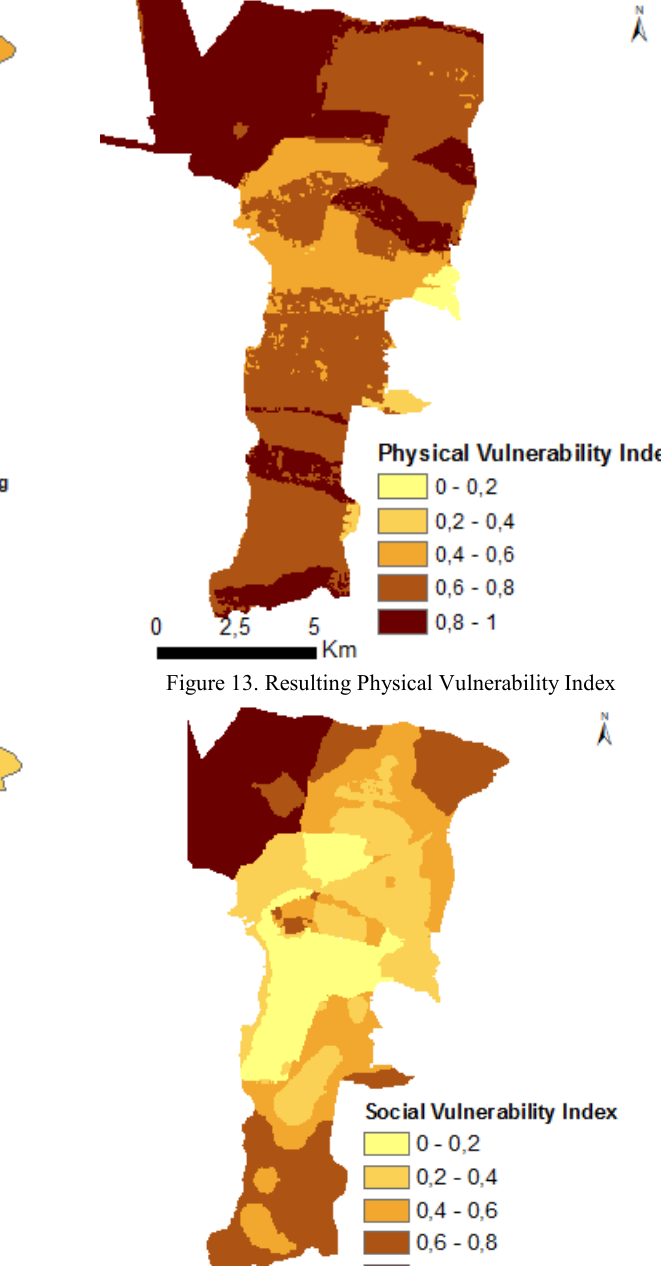
Figure 14. Resulting Social Vulnerability